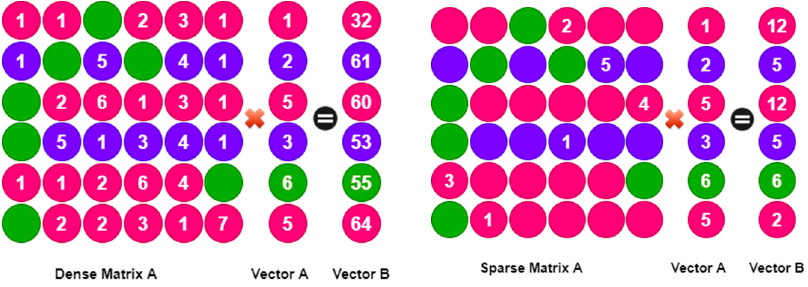
Figure 2. Dense vs. sparse matrix comparison.